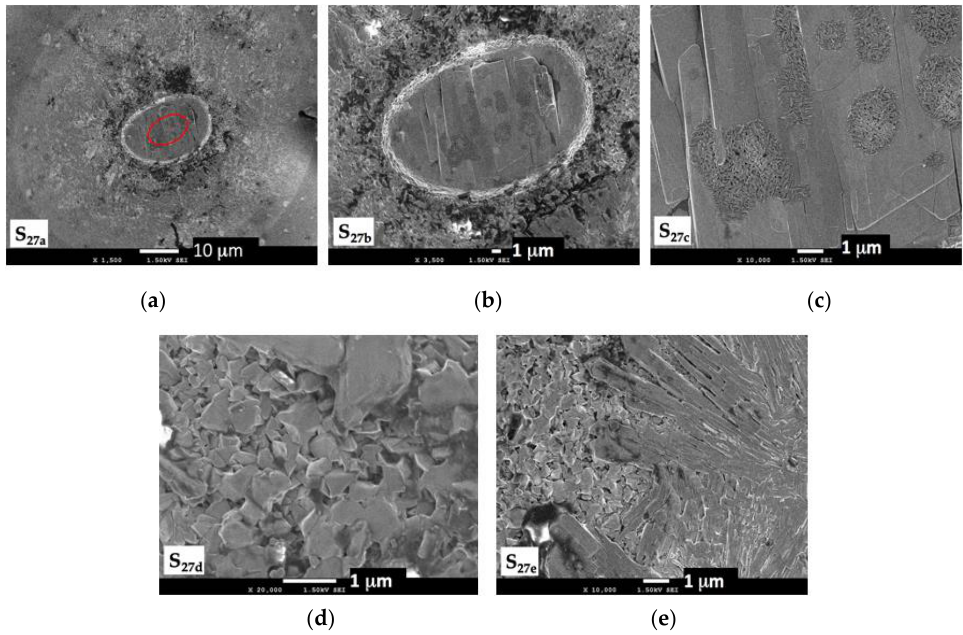
Figure 10. SEM micrograph for the irradiated spot S 27 at per-pulse laser fluence 1.9 mJ/cm 2 and 6 min exposure time. ( a ) S 27a is a wide view of the laser-modified zone; ( b ) S 27b is a close-up of the crater, and ( c ) S 27c is a zoom-in within the crater showing details of the lamellar structure and the nucleating islands; ( d ) S 27d is a magnified image of the edge zone next to the crater; ( e ) S 27e is a magnified image at the zone besides S 27d toward the edge of the laser-modified region.